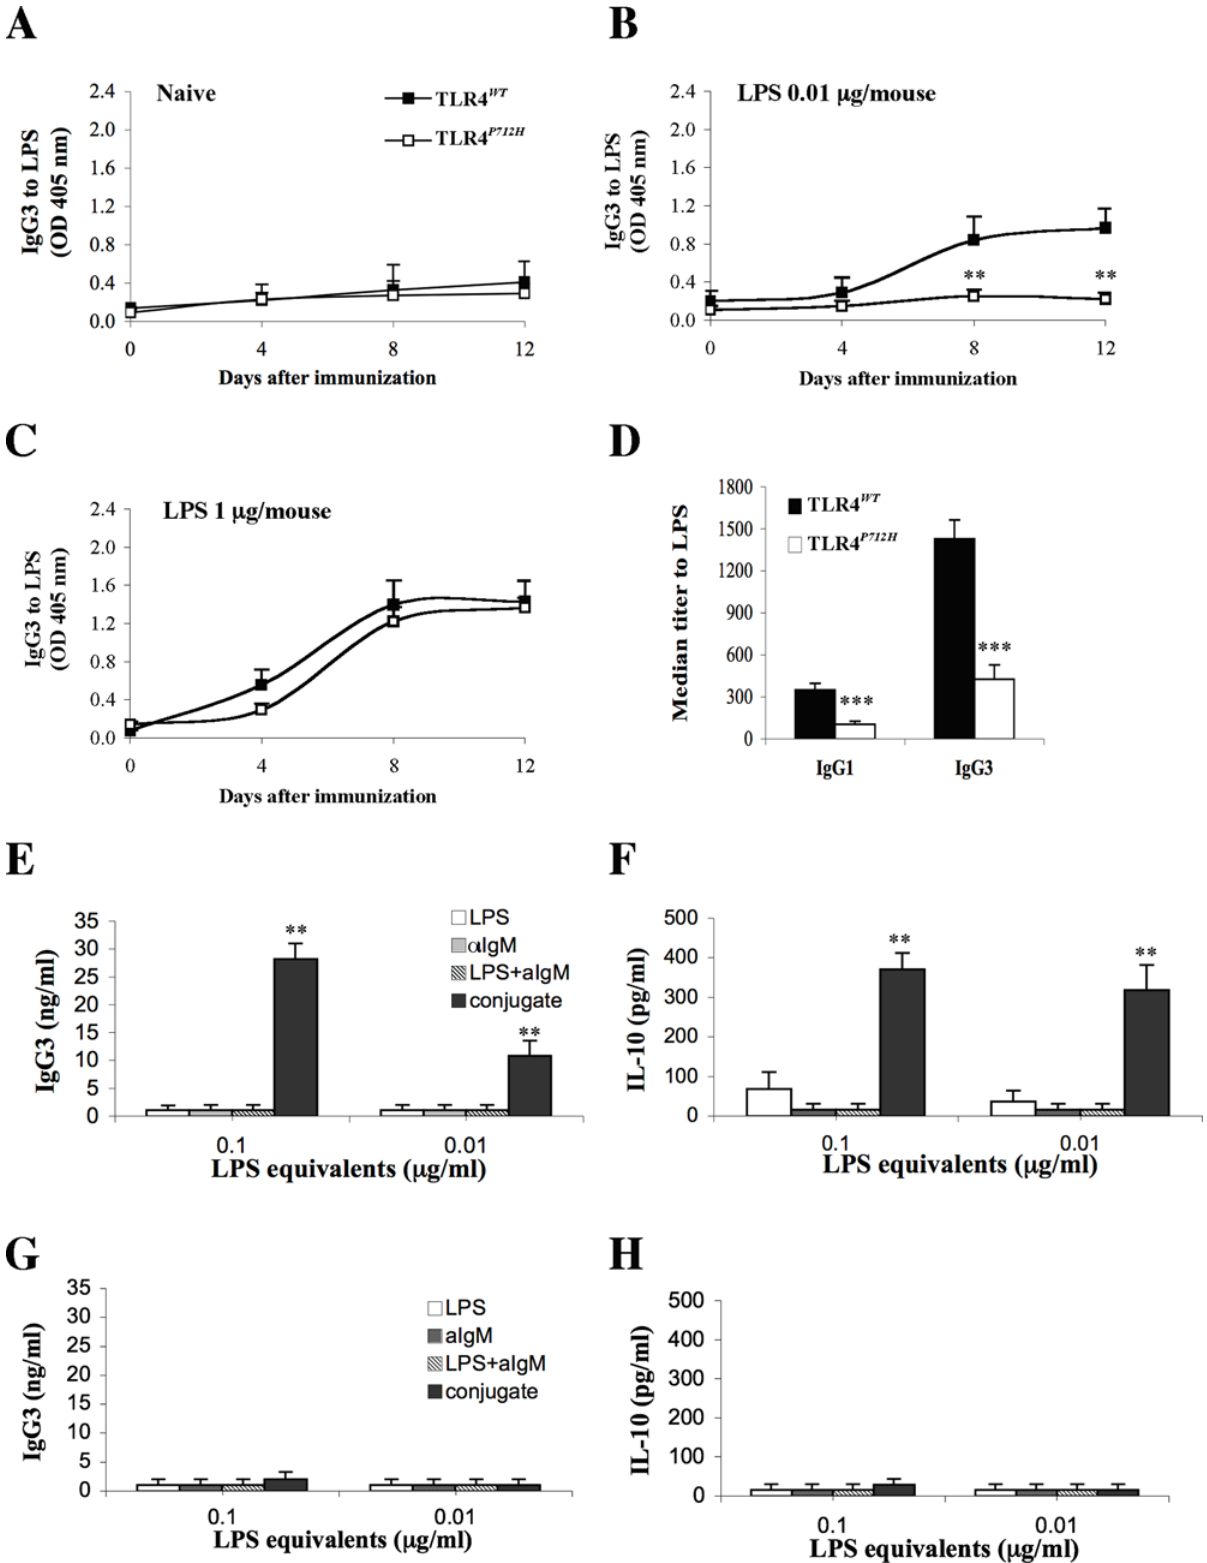
Figure 3. TLR4 and BCR synergize. A–C. TLR4 WT and TLR4 P712H mice were left untreated (A) or immunized with a single low (B, 0.01 m g/mouse) or high (C, 1 m g/mouse) dose of LPS in PBS and IgG3 antibodies to LPS were determined by ELISA. ** P , 0.01 when compared to TLR4 WT mice. D. The titer of antibodies to LPS was determined in the serum samples taken 12 days after immunization with 1 m g/mouse of LPS. Results represent the mean ( 6 SD) of each experimental group (n=5, *** P , 0.001 when compared to TLR4 WT mice). E and F. Purified B cells from TLR4 WT mice were